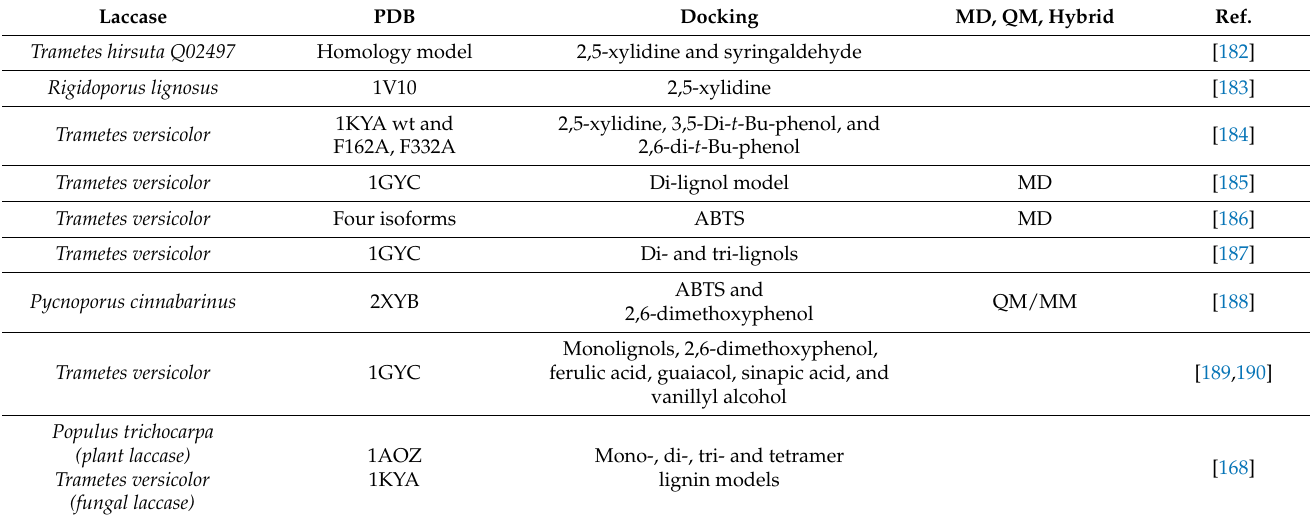
Table 3. Summary of the literature of molecular modeling studies on the interaction between lignin- related substrates or mediators with